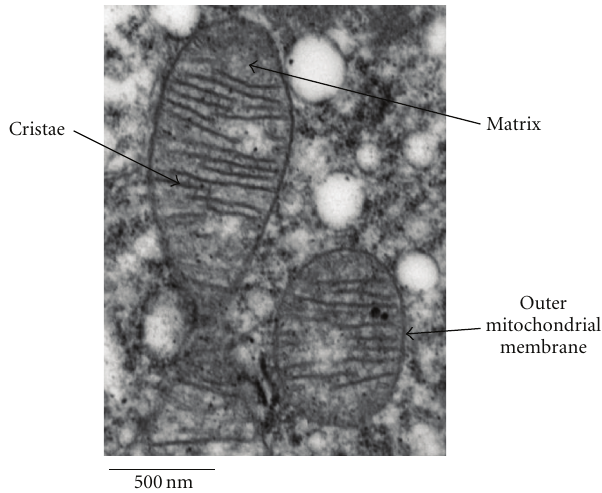
Figure 1: An electron micrograph to show mitochondrial ultra- structure. Reproduced with the kind permissionof Tracy Davey, EM Research Services, Newcastle